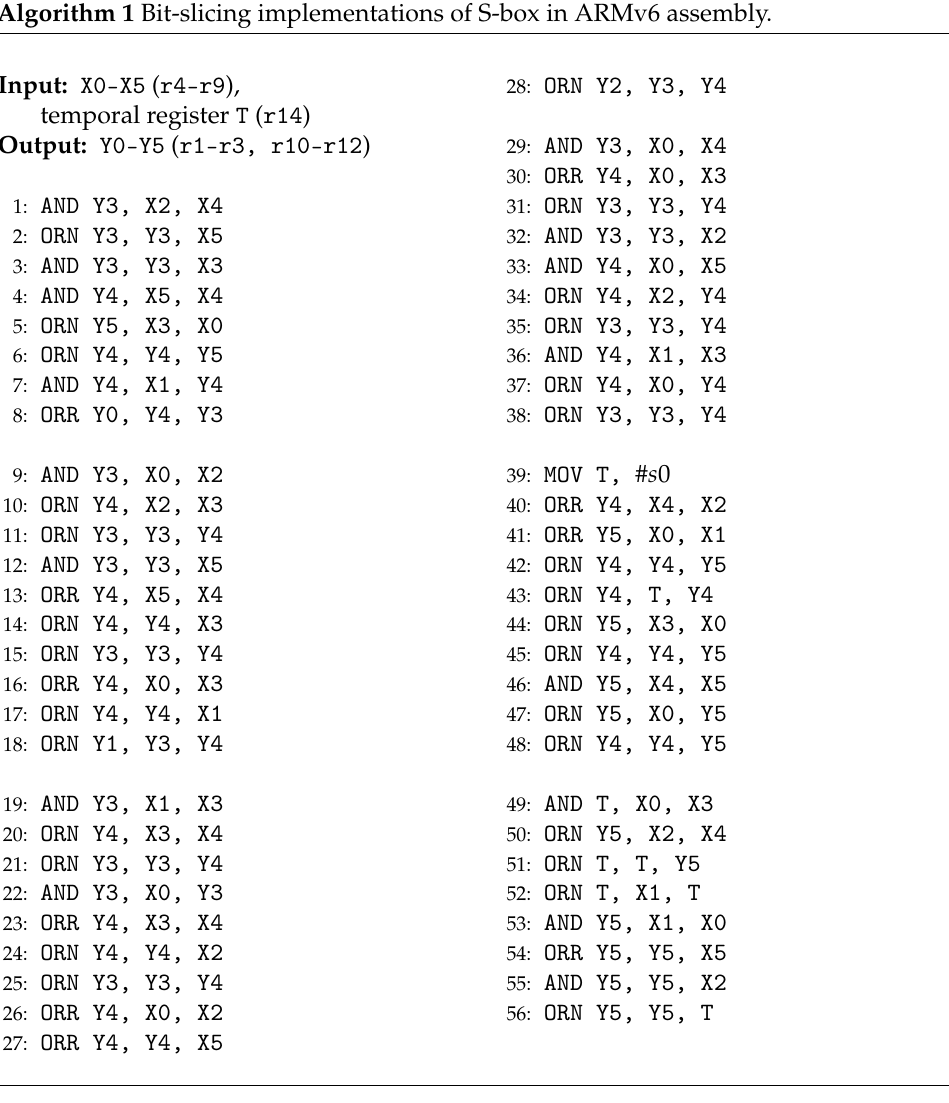
Algorithm 1 Bit-slicing implementations of S-box in ARMv6 assembly.